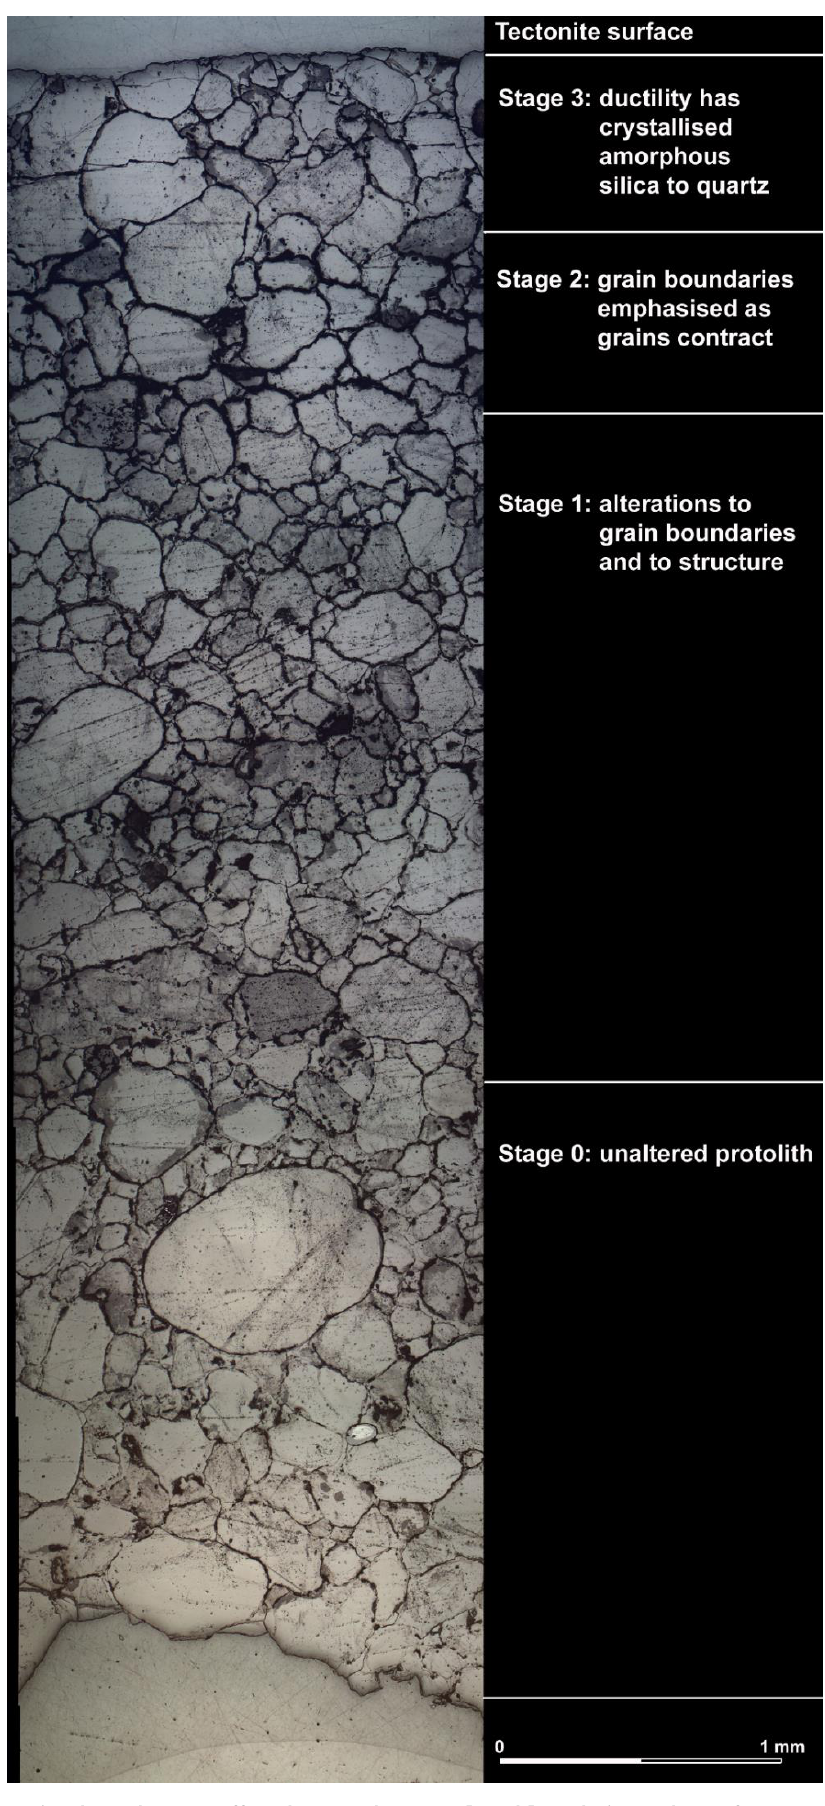
Figure 7. Section through KEM-affected strata, the most altered layer being at the surface, seen at the